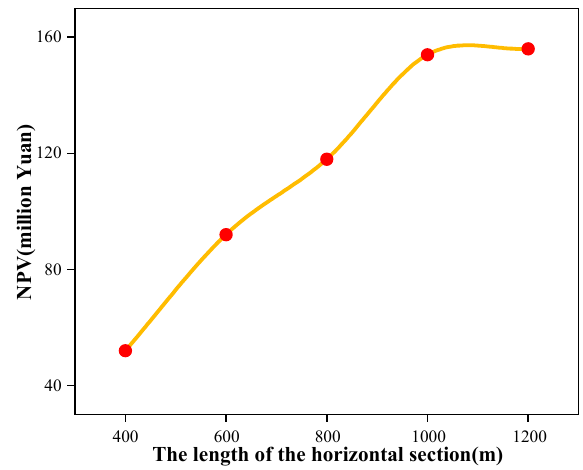
Figure 19. NPV variation with the length of the horizontal section.